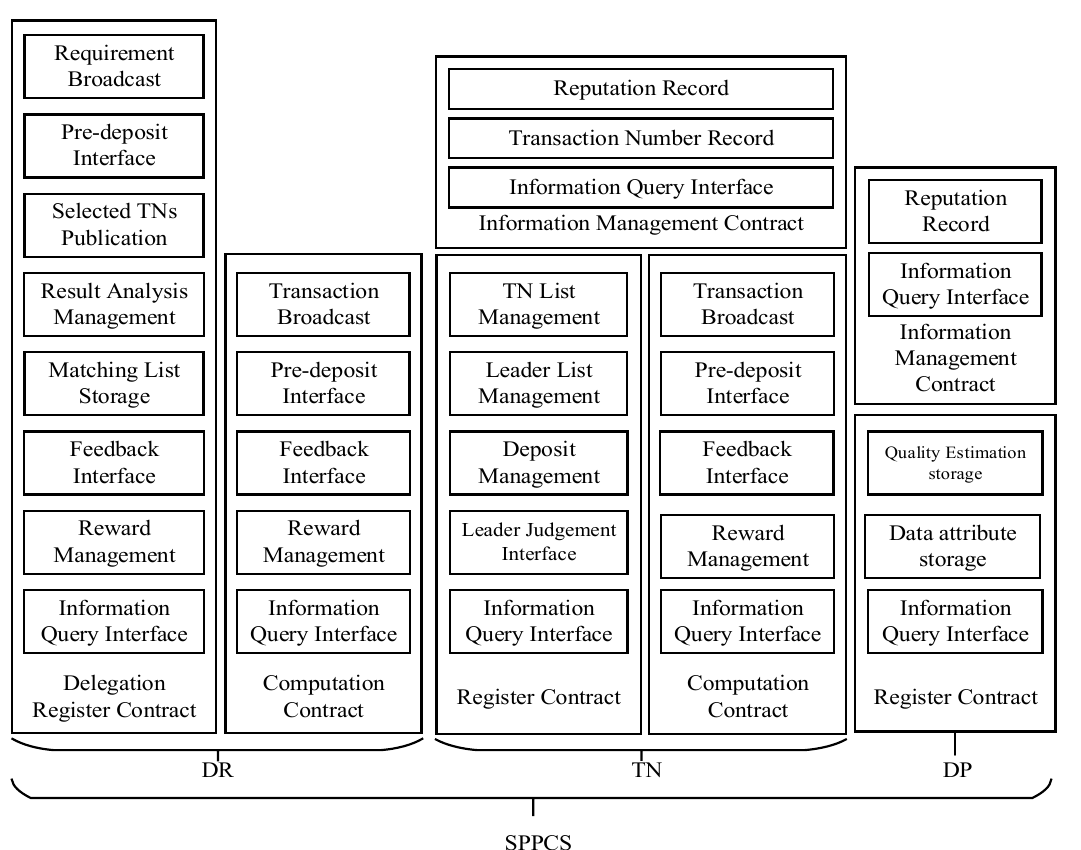
Figure 6. The smart contract of SPPCS.